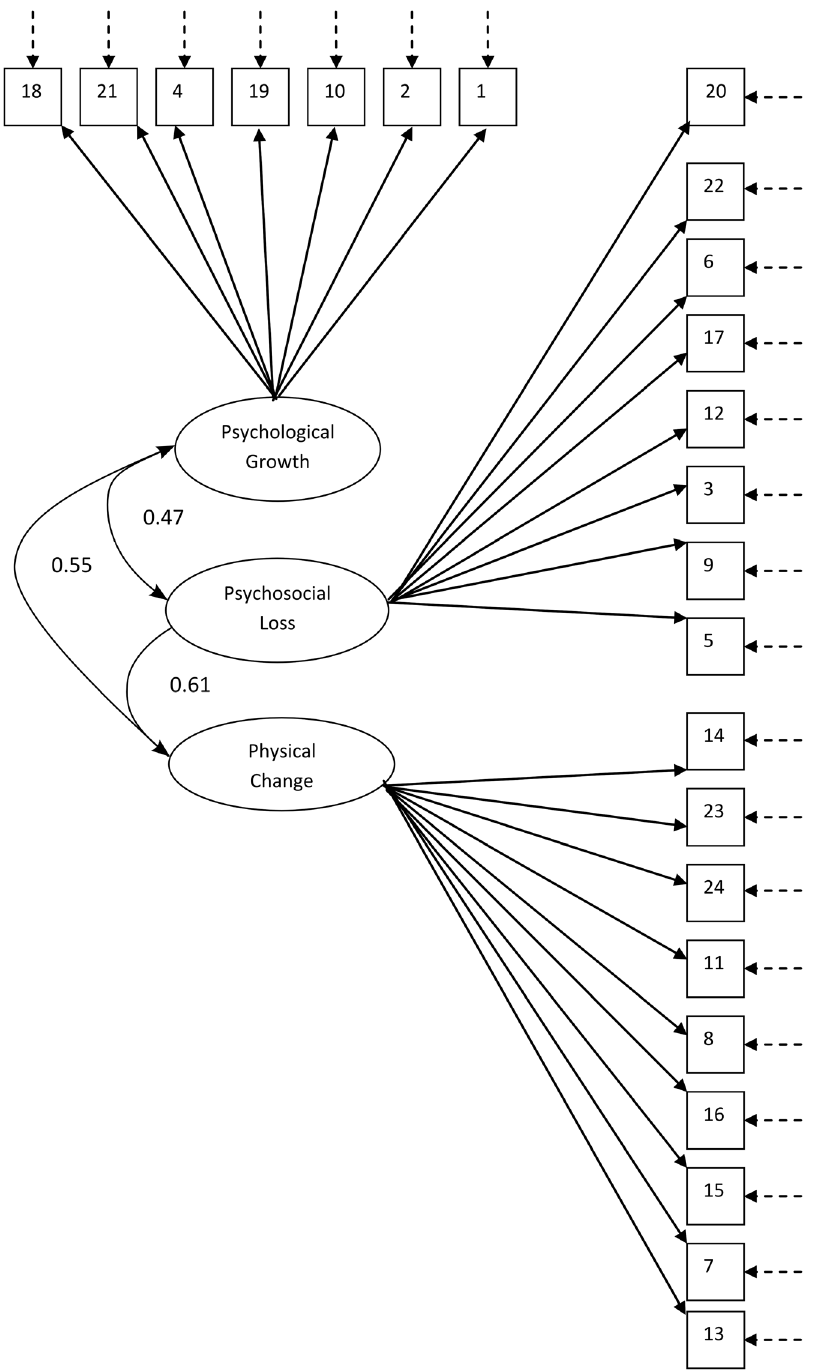
Figure 1. Factor structure of the AAQ scale. Diagrammatic representation of structural equations representing hypothesised model of the relationship between variables in the AAQ. Squares represent the AAQ variables, ovals represent first-order latent variables. Standardised regression weights of first-order factors on second order stress factor are shown; standardised regression weights of SINS items on first-order factors are shown in Table 5; broken arrows represent error variance; intercorrelated error variances are shown in Table 5. model, the value of Chi-square reduced, but the high, significant Pearson’s correlation between the newly identified dimensions value of Chi-square—which should ideally be low and non- of the AAQ and a range of variables is shown in Table 7. Broadly significant—in the final model is probably due to the large sample speaking, the concurrent relationships observed by Shenkin et al , size. 2014 hold in our study. For example, higher levels of disability are negatively correlated with Vitality and positively correlated with